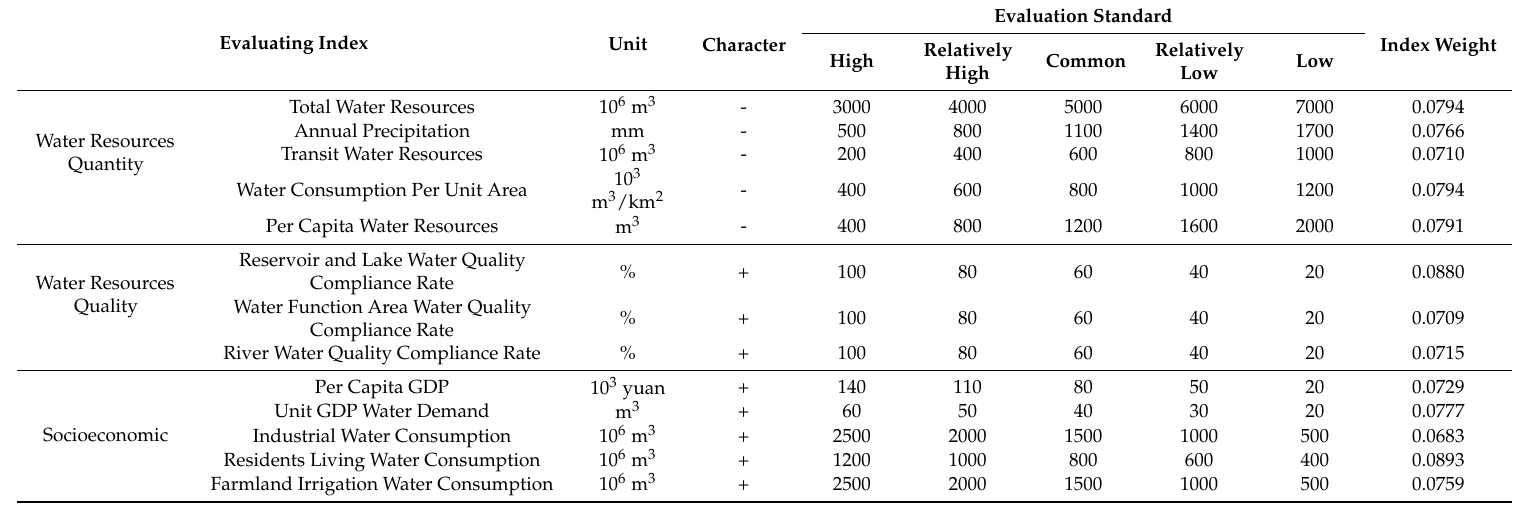
Table 2. Evaluation standard and index weight of water resource